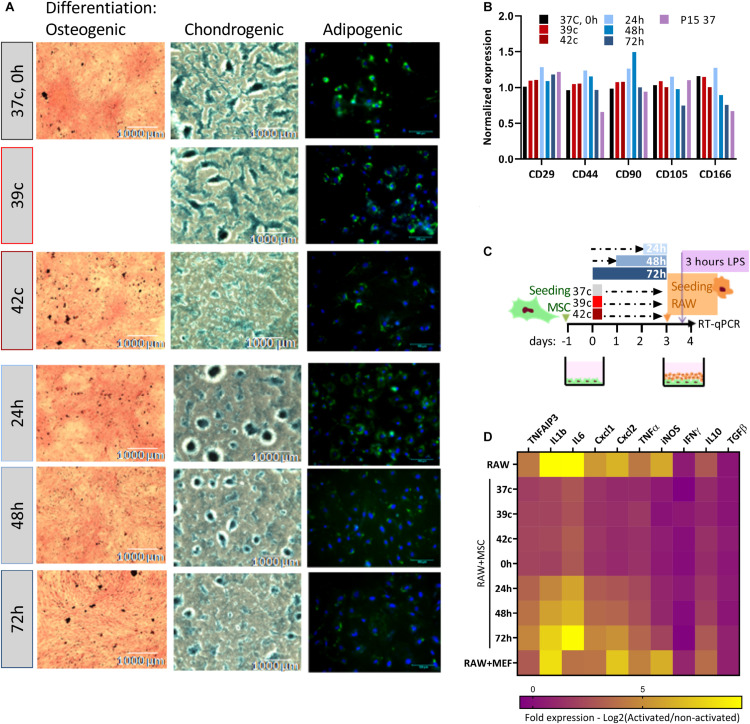
Loss of differentiation and immunomodulation abilities following heat shock. (A) bUC-MSCs gradually lose the ability to differentiate into osteocyetes (left, stained by Alizarin red), chondrocytes (middle, stained by Alcian blue), and adipocytes (right, stained by Bodipy and DAPI) following pulse and constant HS. Representative pictures from three independent experiments are shown. (B) No change in expression levels of typical MSC markers following HS, with all samples normalized to control untreated MSCs. (C) Macrophages cell line (RAW, illustrated orange) was cocultured with bUC-MSCs (in green) for 21 h following HS treatment and then activated by LPS (purple) for 3 h. RAW cells without bUC-MSCs were examined as a reference, and coculture with neutral cells (MEFs) was carried out to control for coculture effect. (D) The transcriptional profile of 10 mouse genes was examined by RT-qPCR. The expression levels of typical proinflammatory genes were high (yellow) in RAW cells alone and reduced (violet) in RAW cells cocultured with bUC-MSCs but not with MEFs. Long HS treatment at 40.5°C eliminated the reduction, indicating that those cells were malfunctioning. Three housekeeping genes were used as reference genes—UBC, EIF5a, and EEF1A1. Data are the mean for n = 3.